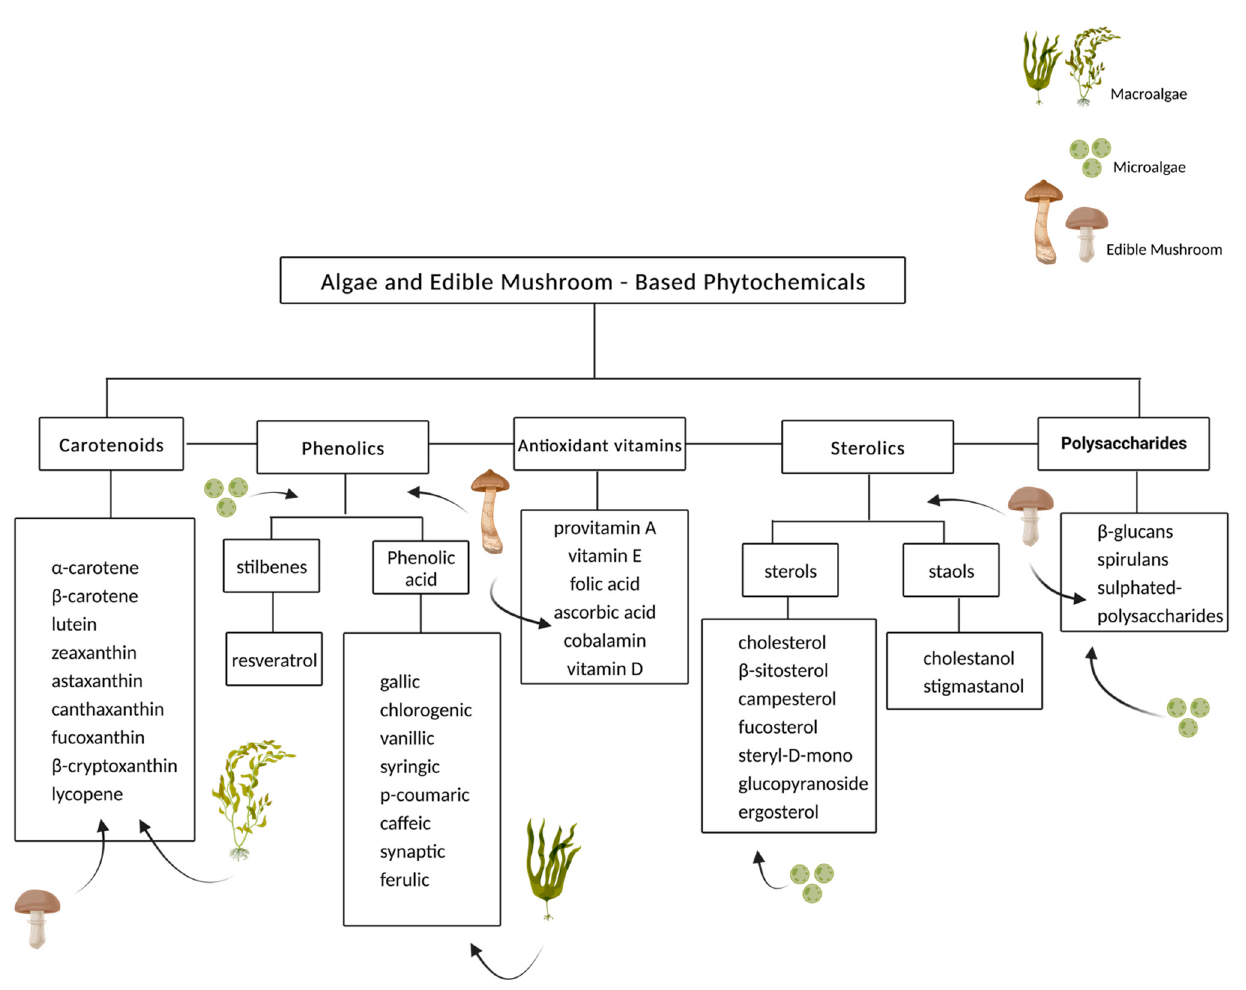
Figure 4. Scheme of alga- and edible mushroom-based phytochemicals. Phytochemicals are sec- ondary metabolites and bioactive compounds naturally found in plants and organisms such as microalgae, macroalgae and edible mushrooms. Among phytochemicals, there are carotenoids, sterols, polysaccharides, and phenols that have biological activity that affects human health. Many phytochemicals act as antioxidants; others succeed in suppressing harmful processes in the body’s cells, preventing the proliferation of cancer cells, regulating lipid levels and having anti-inflammatory activity. (Created with BioRender.com (accessed on 1 September